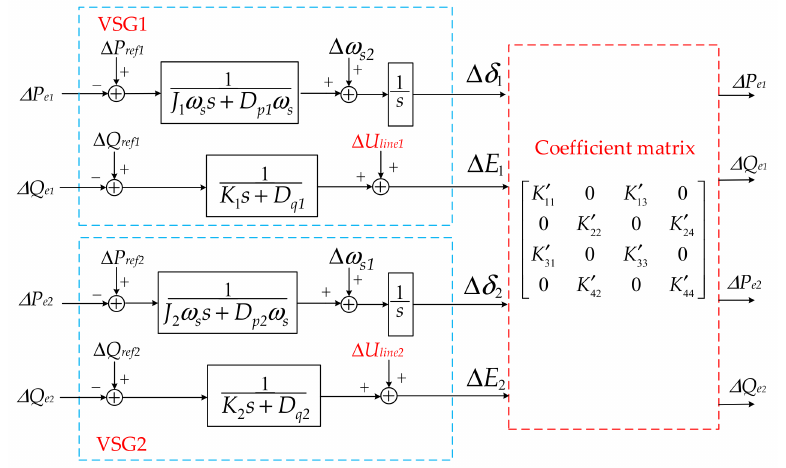
Figure 5. Block diagram of the small-signal control of the two-machine parallel